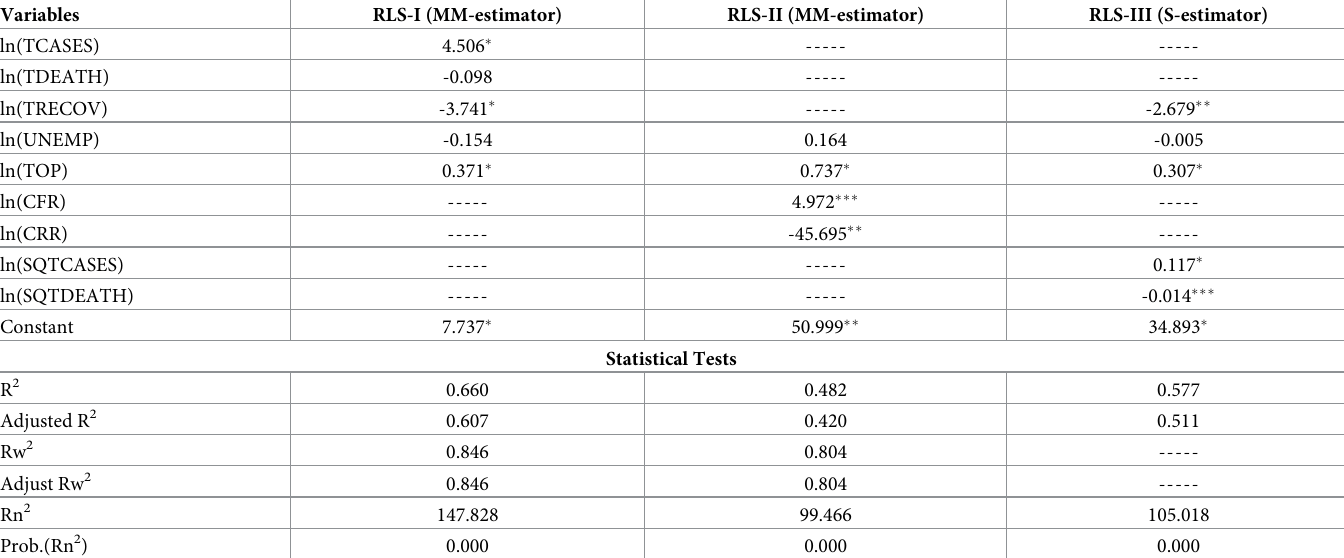
Table 4. Robust least squares regression for ln(GDP).